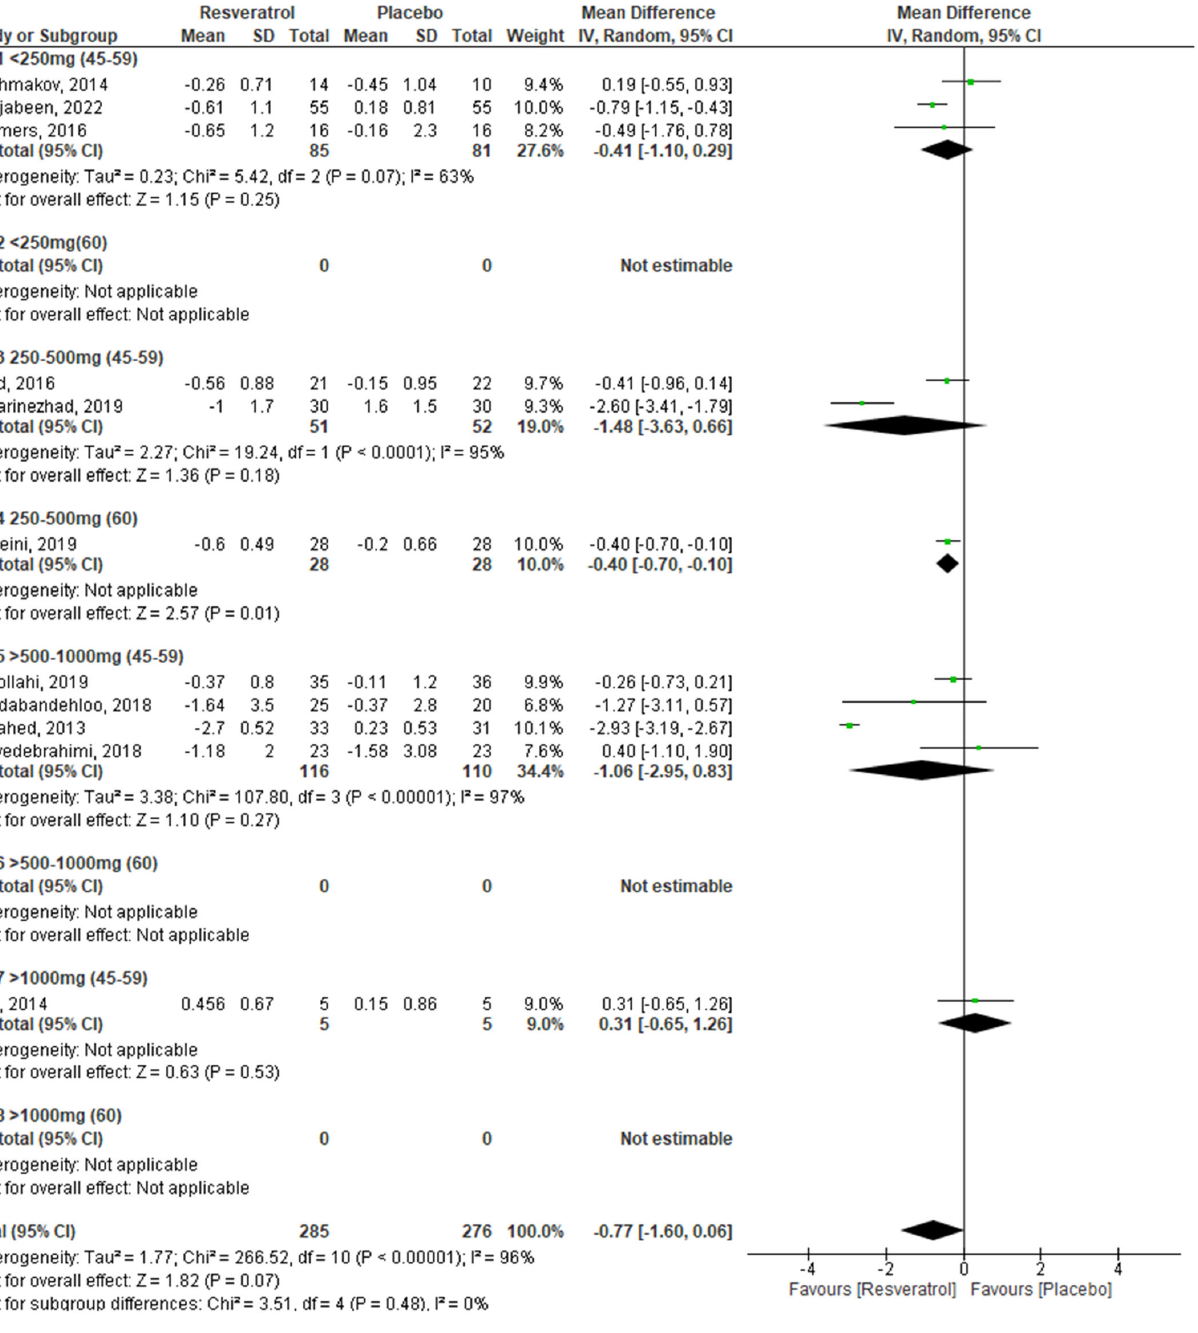
Figure 6. Effect of RV on HOMA ‐ IR, stratified by age and dose.